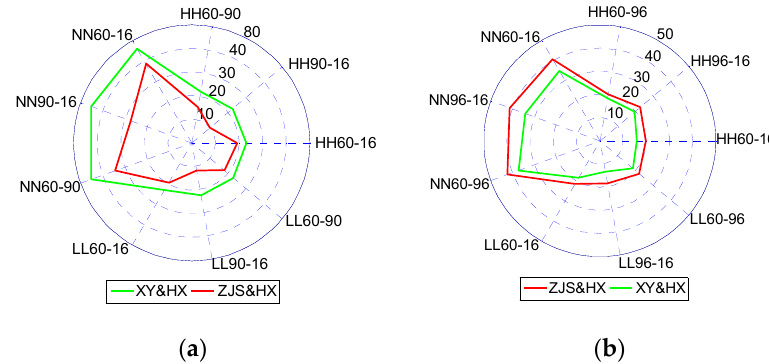
Figure 6. Probability of synchronous high–low runoff–sediment of the two stations. Note: HH stands for synchronous high runoff/sediment of the two stations; NN stands for normal runoff/sediment of the two stations; LL stands for synchronous low runoff/sediment of the two stations; and 60–90 stands for the time interval of 1960 to 1990, and similarly for the others. ( a ) is the probability of synchronous high–low runoff of the two stations, with unit of %; and ( b ) is the probability of synchronous high–low sediment of the two stations, with unit of